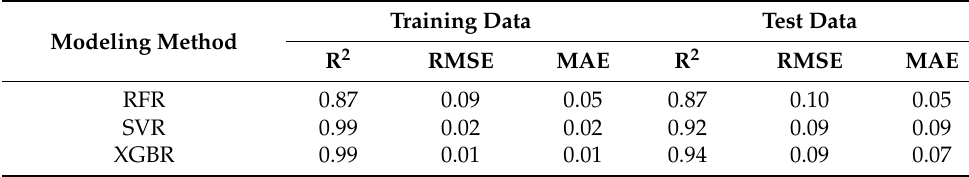
Table 3. Inversion accuracy of NCPI using different regression models.